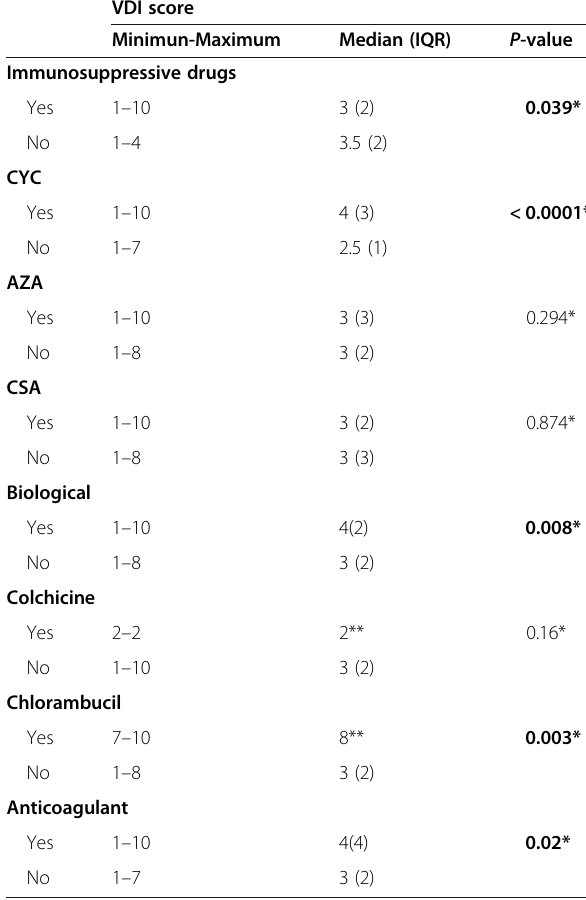
Table 4 Comparison of Vasculitis Damage Index (VDI) with respect to the medication received